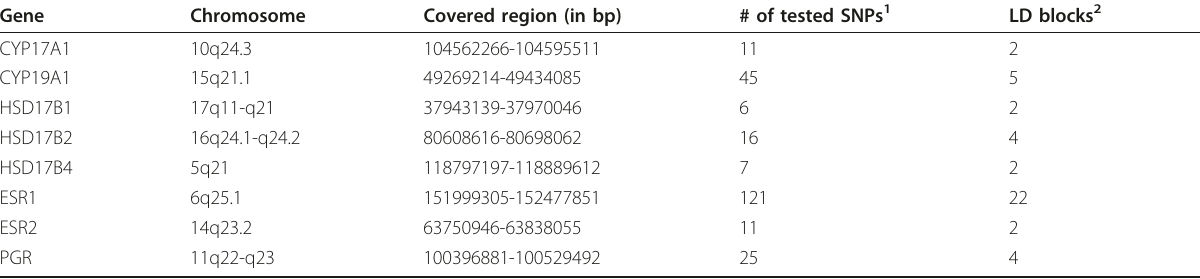
Table 1 Characteristics of the selected sex-steroid synthesizing enzymes and receptors Gene